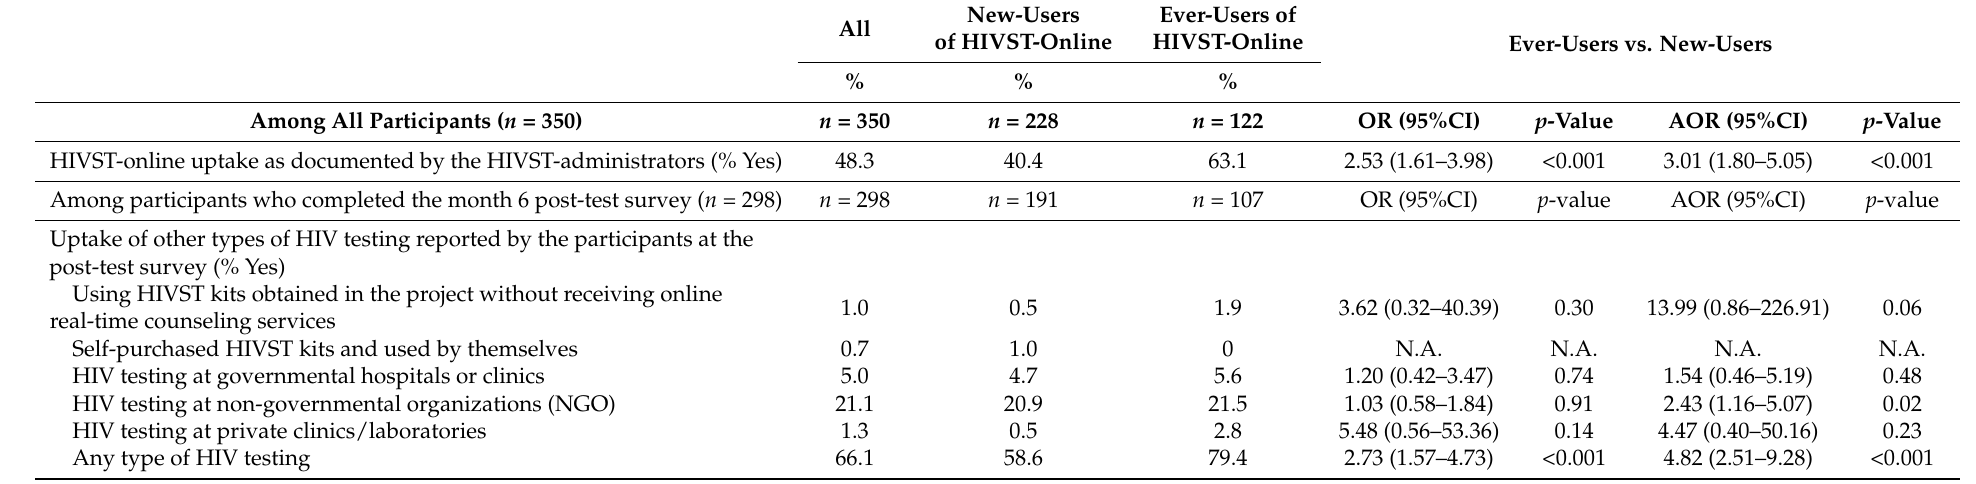
Table 2. Types of HIV testing taken up by the participants during the follow-up